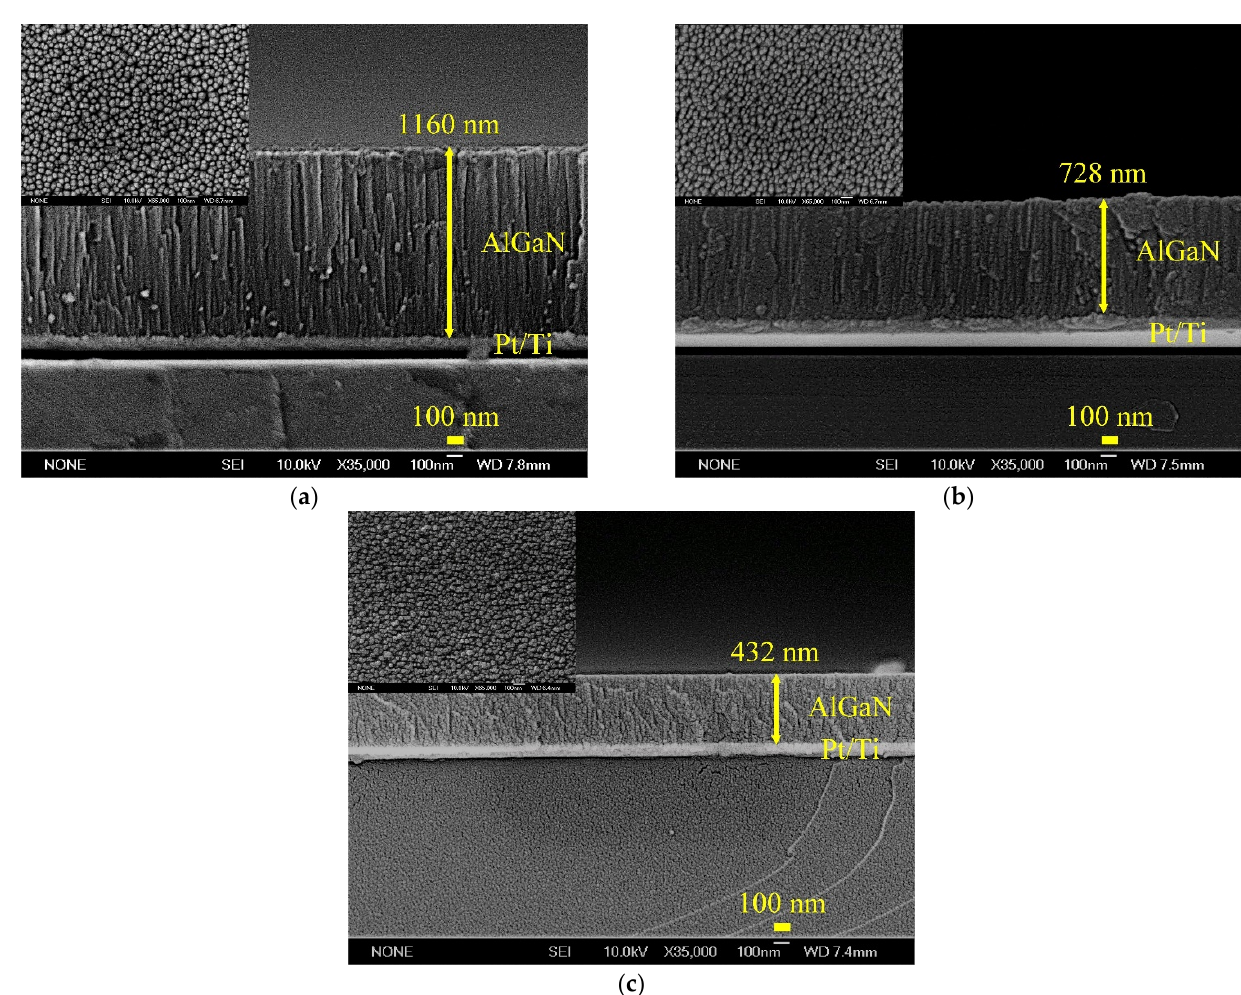
Figure 3. The surface morphologies and cross-sectional images of AlGaN films deposited under different sputtering pressures; ( a ) 10 mTorr, ( b ) 20 mTorr, and ( c ) 30 mTorr.